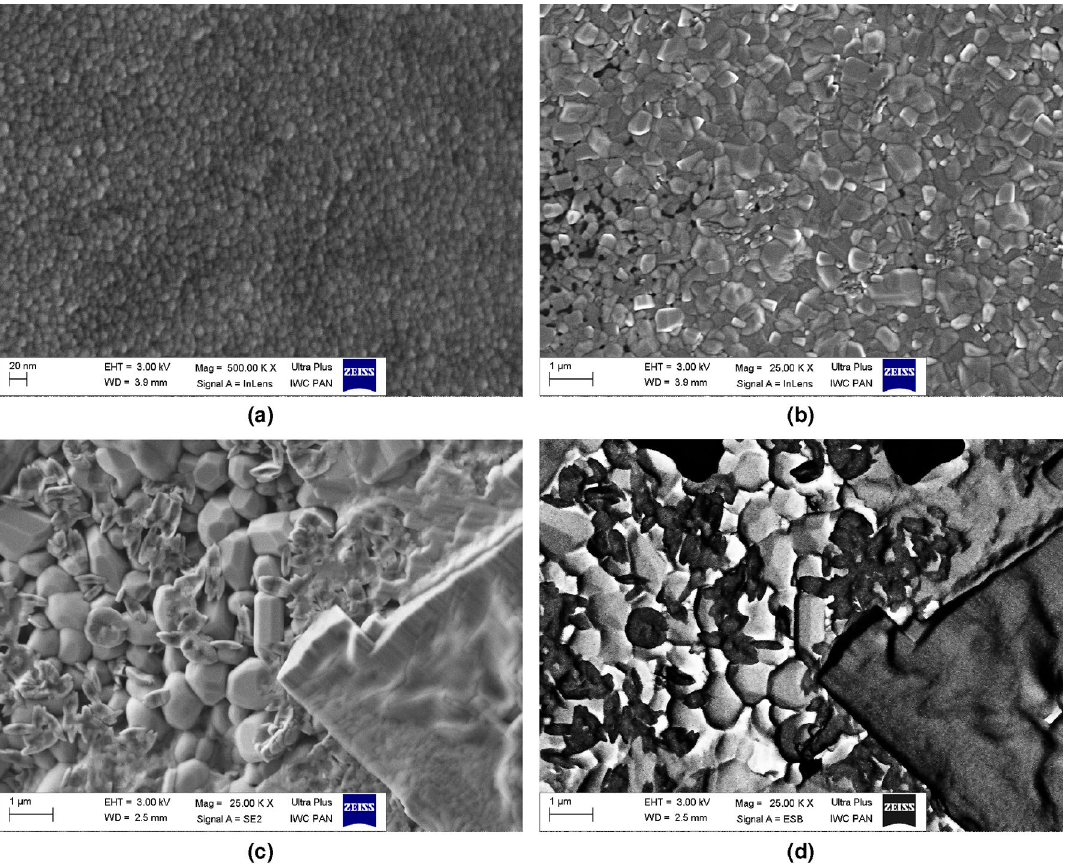
◦ Figure 6. Representative SEM images of three phases—( a ) δ – MQ-1100-30 heated up to 630 C; ( b ) β — ◦ ◦ MQ-1100-30 heated up to 730 C; ( c,d ) γ – MQ-1100-15 heated up to 730 C—stabilized in glass-ceramics. One can see that average size of grains increases significantly from ca. 10–20 nm (for δ phase) to sub-micron (for γ phase). Differences in local compositions were pronounced only for the samples with the γ phase, as evidenced in electron backscattered mode ( d